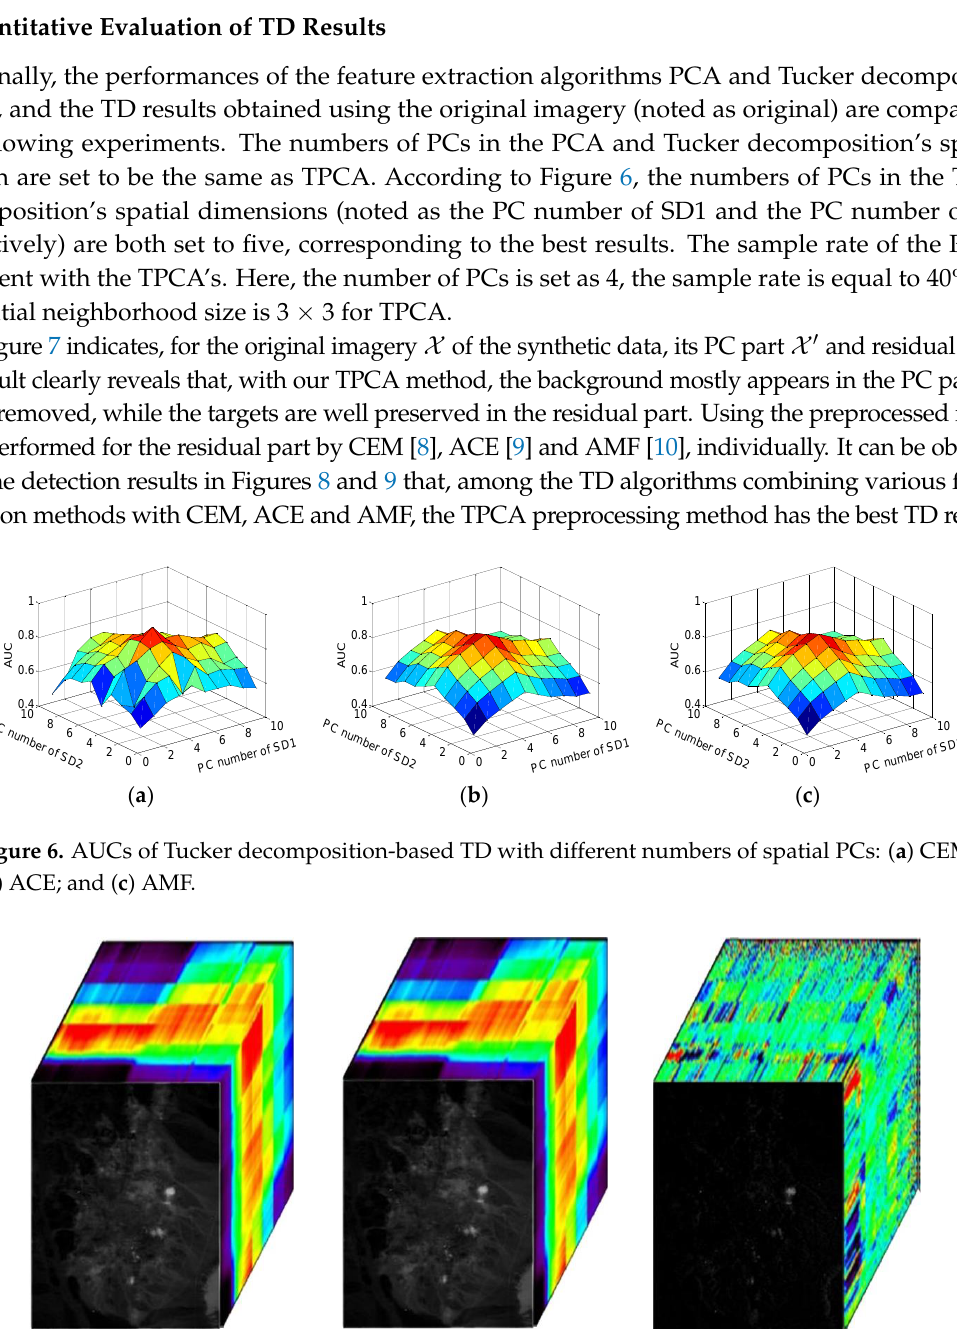
Table 3. AUCS and running time with different neighborhood sizes.